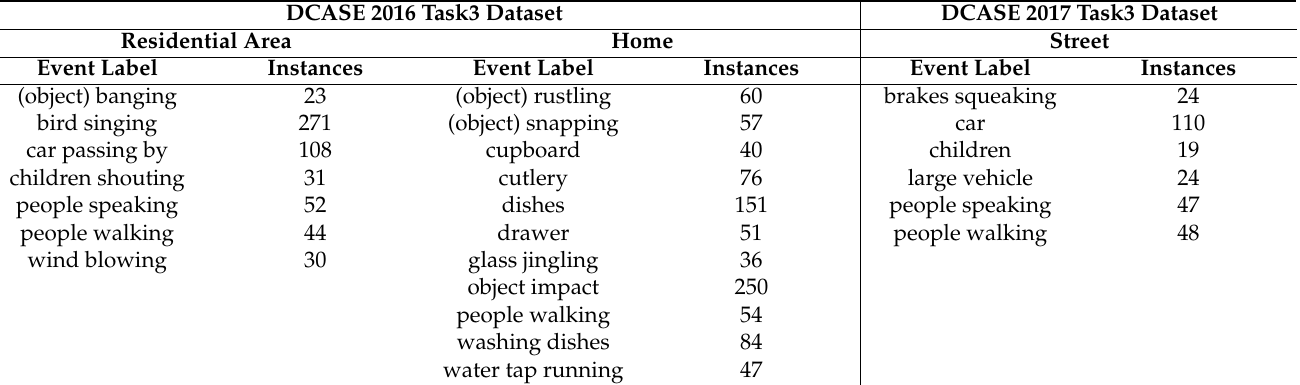
Table 1. Event instances per class in DCASE 2016 Task 3 dataset and DCASE 2017 Task 3